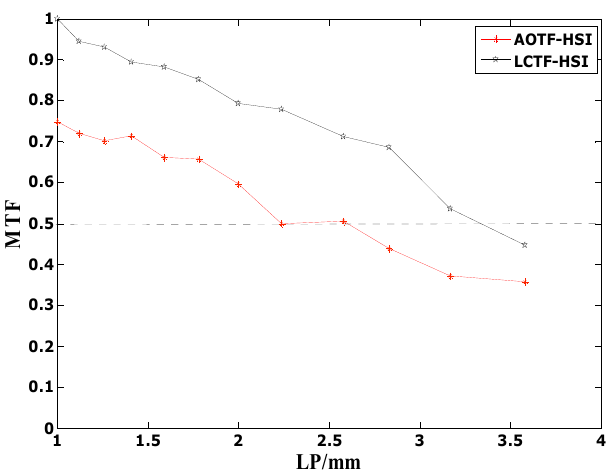
Figure 8. Modulation transfer function of both tunable filters, LCTF and AOTF, imaging USAF-1951 reflection pocket target group 0 and 1.